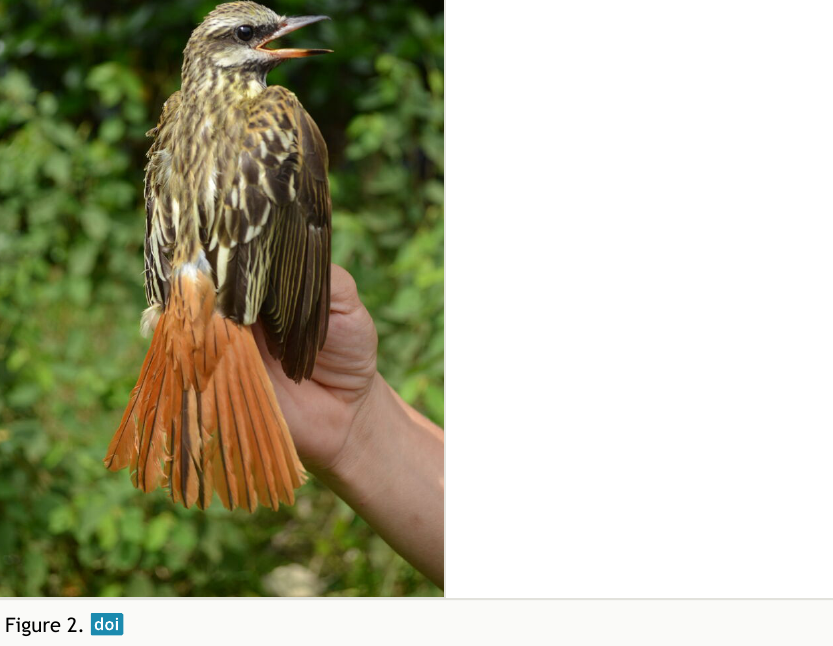
Myiodynastes luteiventris (but see Discussion), a boreal migrant, was initially identified in the field as Myiodynastes maculatus and was subsequently re-identified with the help of its COI barcode (BOLD ID).